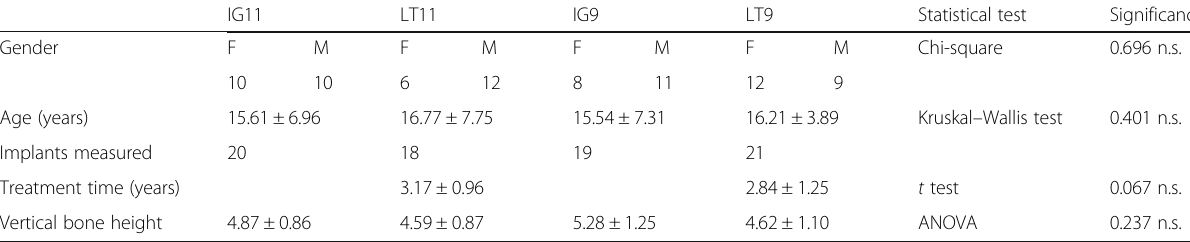
Table 1 Descriptive statistics and matching of the groups